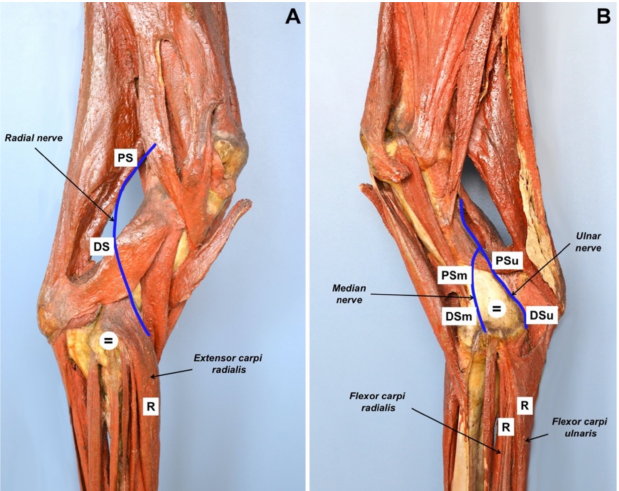
Figure 2. Photographs demonstrating the position of electrodes during motor NCS on an anatomical model of bovine right thoracic limb. ( A ) Lateral view. The stimulating needles for the radial nerve were placed at the angle between the head of the humerus and the ventral portion of the scapula (PS) and at the third distal of the humerus, caudally to the brachialis muscle (DS). The position of ground needle (=) and recording needle (R) is also shown. ( B ) Medial view. The stimulating needles for the ulnar nerve (PSu, DSu) were placed caudally to the medial humerus epicondyle; the stimulating needles for the median nerve (PSm, DSm) were placed cranially to the medial humerus epicondyle. The position of ground needle (=) and recording needles (R) is also shown. (Courtesy